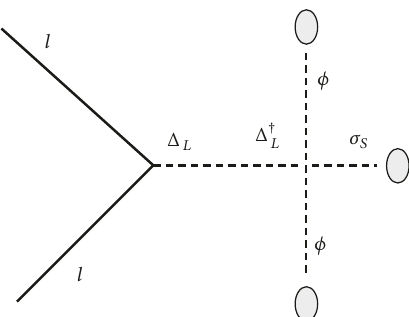
Figure1:Feynmandiagramrepresentingtype-IIseesawmechanism for neutrino mass generation in SU (5) . Scalar fields 𝜙,𝜎 푆 , and Δ 퐿 represent SM Higgs doublet, singlet, and LH triplet as defined in the text. This diagram defines the trilinear coupling mass 𝜇 Δ = 𝜆⟨𝜎 푆 ⟩